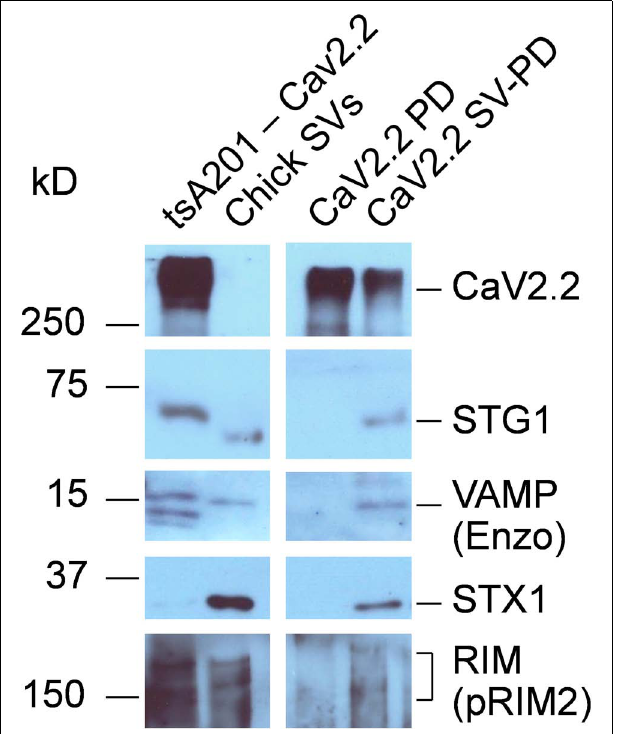
FIGURE 5 | SV-PD by expressed CaV2.2. CaV2.2 channels were expressed in tsA201 cells.Western blot of these cells exhibited bands corresponding to the channel and also SV protein proteins TsA201-CaV2.2 . The cells were solubilized in RIPA buffer and their CaV2.2 channels were captured on IP beads, as described.The immobilized CaV2.2 was then incubated either with either solubilized ( CaV2.2 PD ) or intact ( CaV2.2 SV-PD ) SVs, purified from chick brain as described.With the exception of a faint band for RIM ( contrast enhanced ), no SV proteins were co-precipitated using the solubilized SVs ( CaV2.2 PD ), and hence, these proteins were neither retained from the original cell lysate nor bind to the channel directly from the solubilized SVs. However, marker proteins were captured when the beads were exposed to intact SVs ( CaV2.2 SV-PD ), consistent with capture of the entire SV, even though the lighter CaV2.2 band indicating that somewhat less IP beads were used.The un-evenness in the STG1 band reflects a minor discontinuity in the gel (the antibody is highly selective). STX1 serves here as an additional SV marker (as in Figure 3 ). Similar results were observed in three separate experiments.